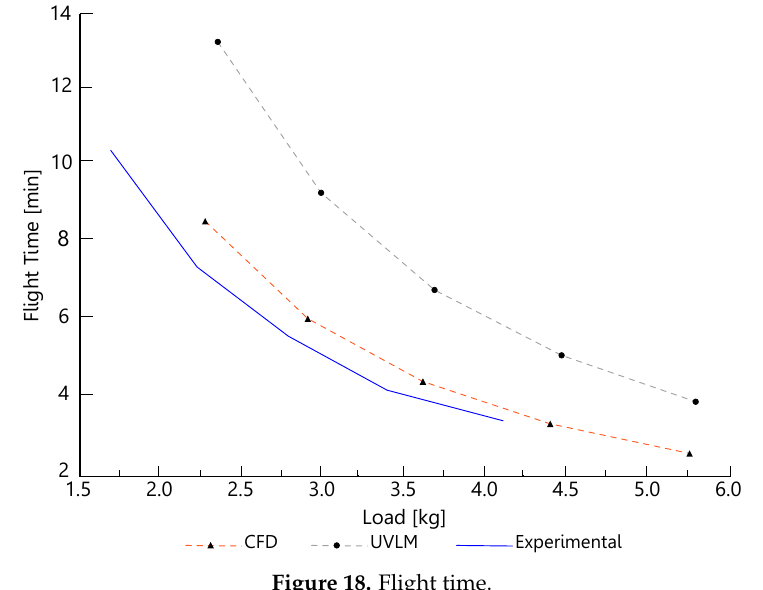
Figure 18. Flight